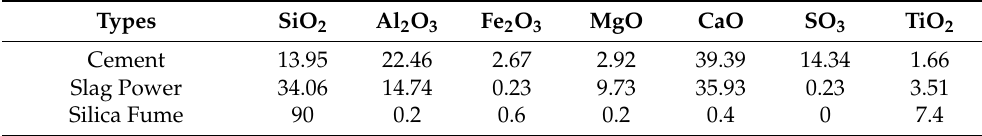
Table 2. Chemical composition of the cementitious materials.